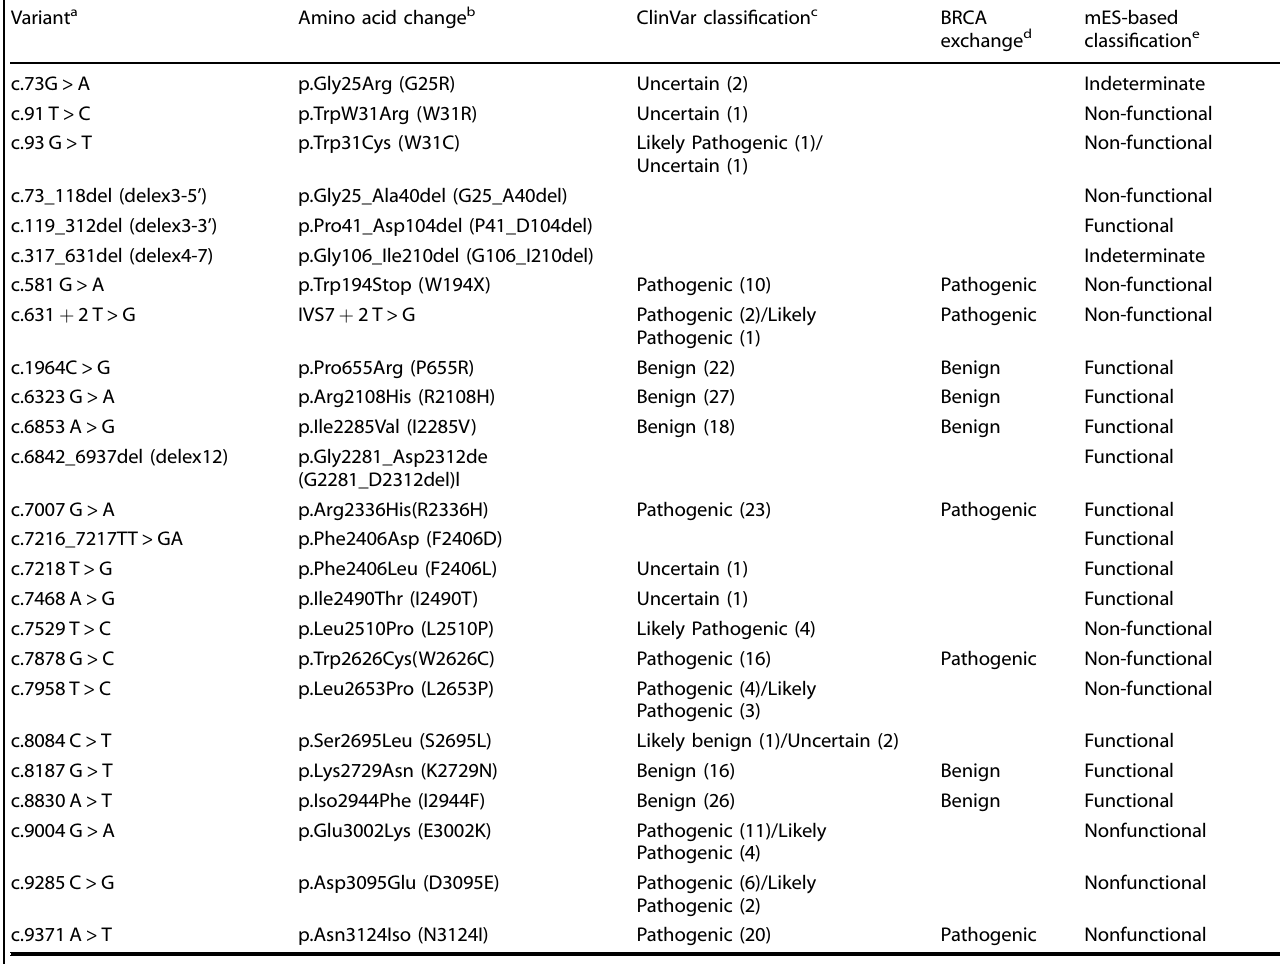
Table 2. BRCA2 variants used to test the performance of the VarCall